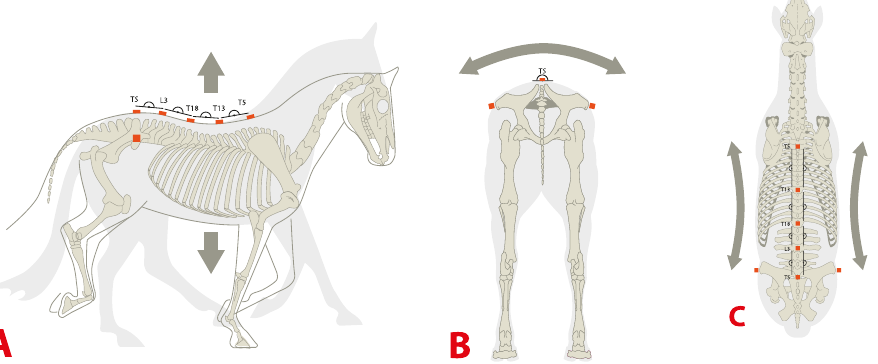
Figure 2. IMU sensor locations in the thoracolumbosacral region and illustration of rotational movement parameters. Differential pitch, roll and heading rotational movements were calculated between adjacent sensors positioned at T5, T13, T18, L3 and TS. Sensor pouches were used for the left and right tubera coxae. ( A ) = pitch, ( B ) = roll and ( C ) = heading.